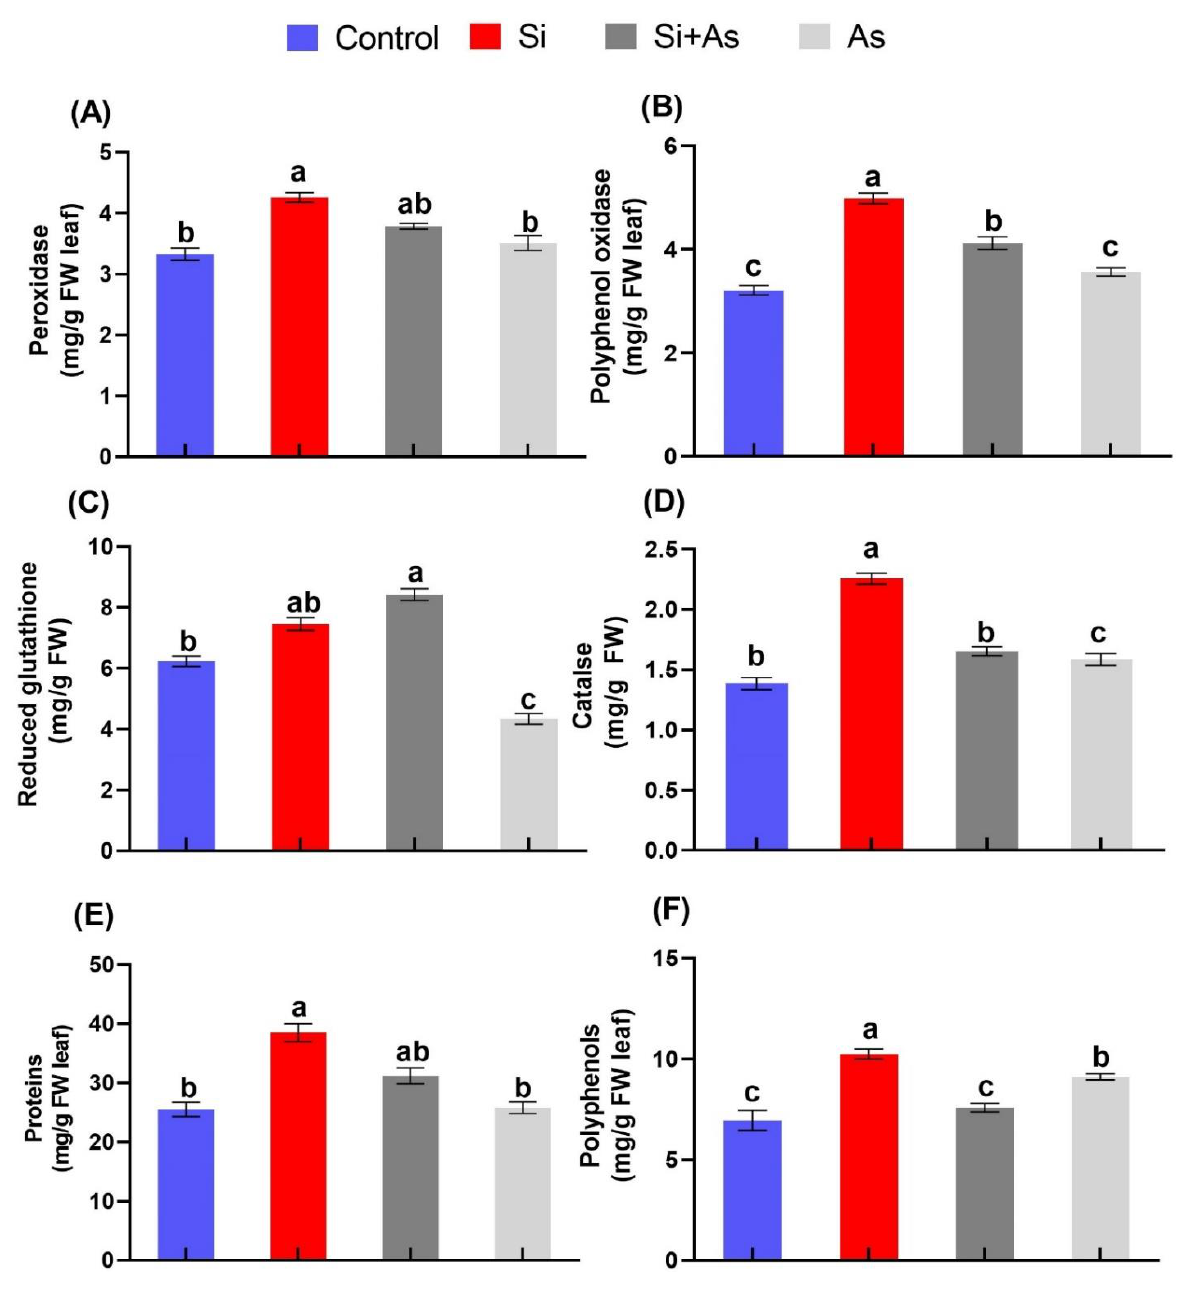
Figure 4. Stress alleviating effects of silicon (Si) exogenously applied, on antioxidants. ( A ) Peroxidase (POD), ( B ) polyphenol oxidase (PPO), ( C ) reduced glutathione (GSH), ( D ) catalase (CAT), ( E ) proteins contents, and ( F ) total polyphenol (TPP), in date palm under heavy metal stress conditions. Means for all respective treatments were used to determine significant difference ( p > 0.05) via Duncan’s multiple range test (DMRT). Letters show significant difference and values represent mean (of 4 replicates) ± standard